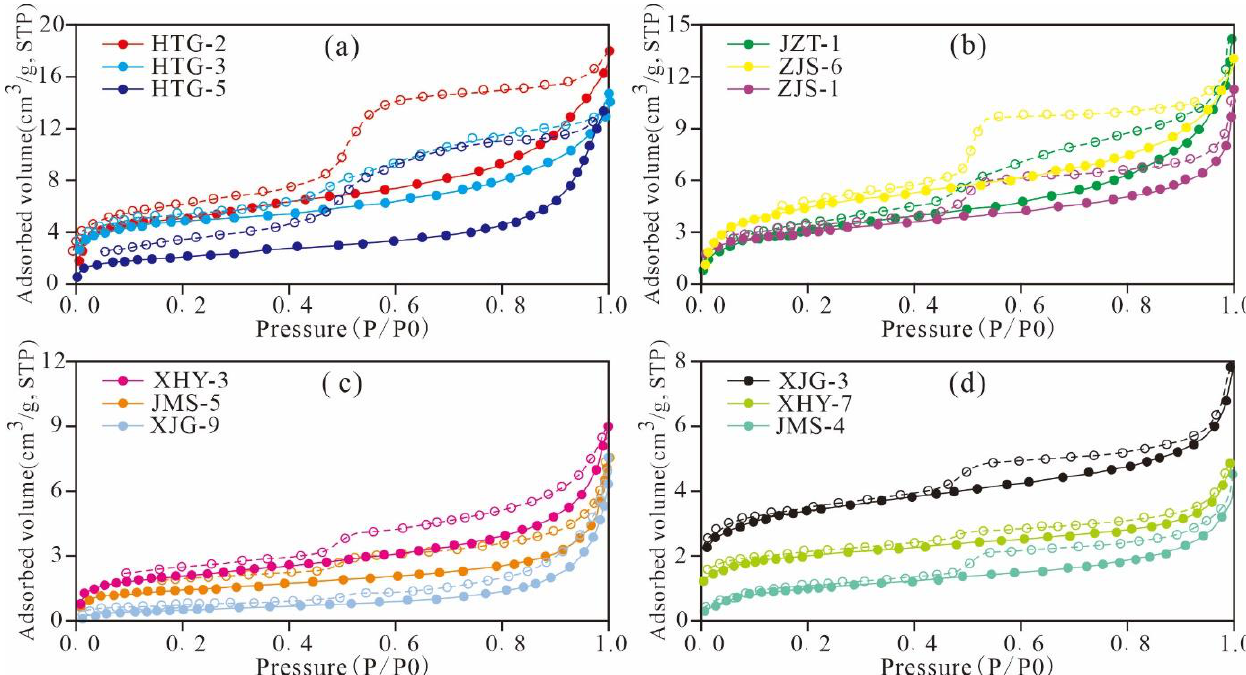
Figure 3. N 2 adsorption and desorption isotherms of representative samples of the Mesoproterozoic Xiamaling shale in Zhangjiakou, Hebei (( a ), the first type of N 2 adsorption curve; ( b ), the second type of N 2 adsorption curve; ( c ), the third type of N 2 adsorption curve; ( d ), the fourth type of N 2 adsorption curve).